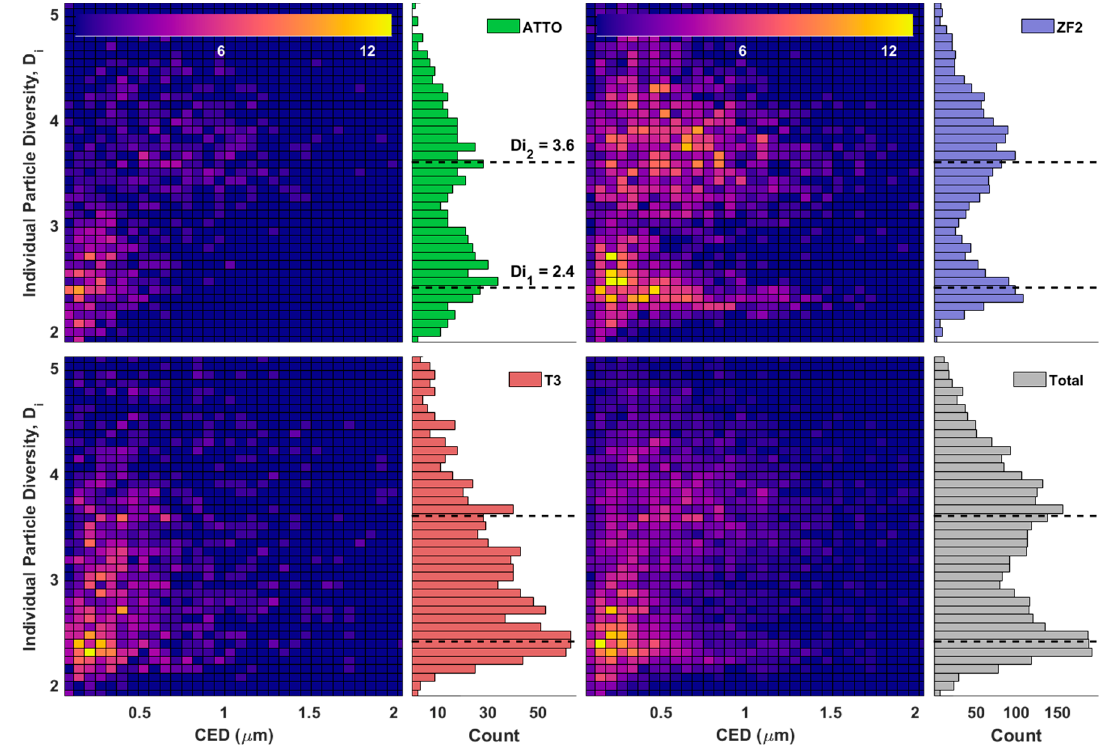
Figure 8. Histograms of individual particle diversity values for each sampling site and the combined data set of all three sites. The individual diversity values for the two modes are indicated with dashed lines and were calculated by fitting two Gaussian distributions to the total data set histogram. Bin counts for 2D histograms are represented by color values shown at the top.